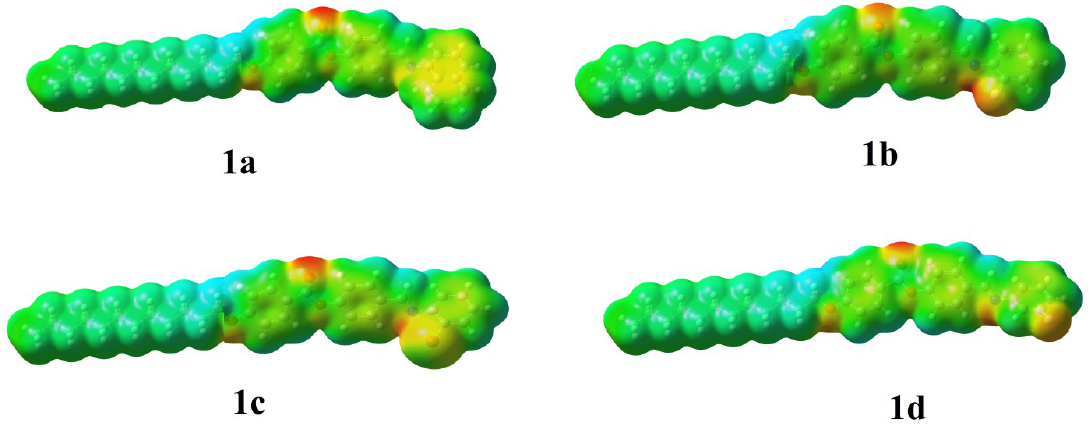
Figure 7. Molecular electrostatic potentials (MEP) of Ia–d .